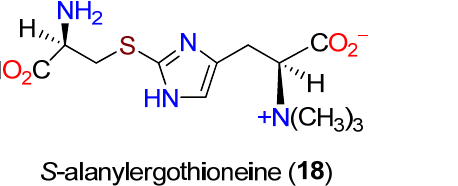
Figure 3. Structures of S -alanylergothioneine ( 18 ) and 19 .